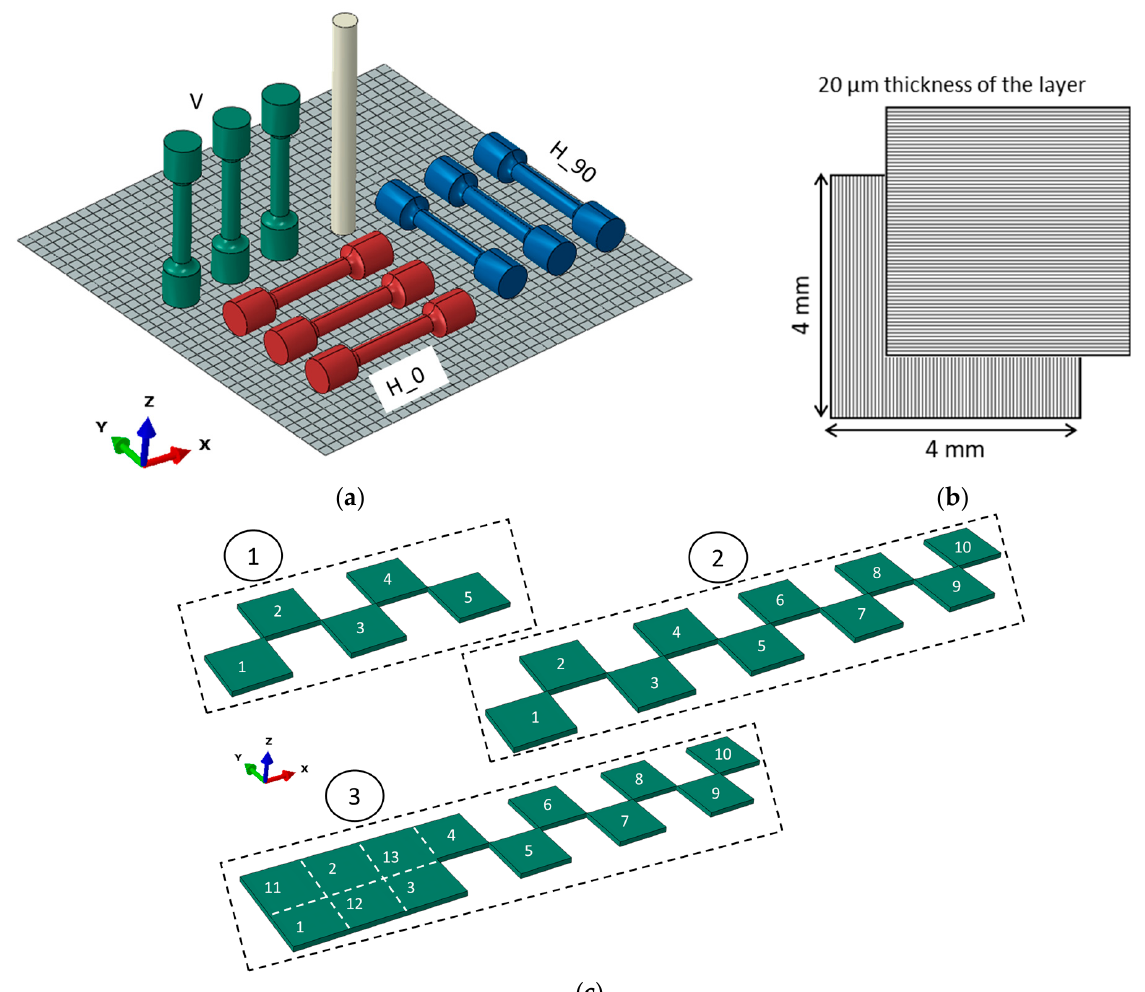
Figure 1. ( a ) Scheme of experimental set on build platform, ( b ) square pattern, ( c ) example of patterns formation sequence for the horizontal H_0 specimens.